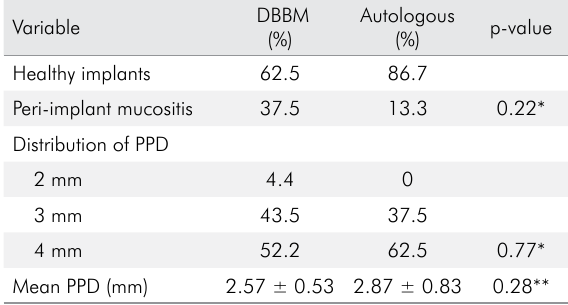
Table 5. Peri-implant clinical parameters in the two groups at the end of the